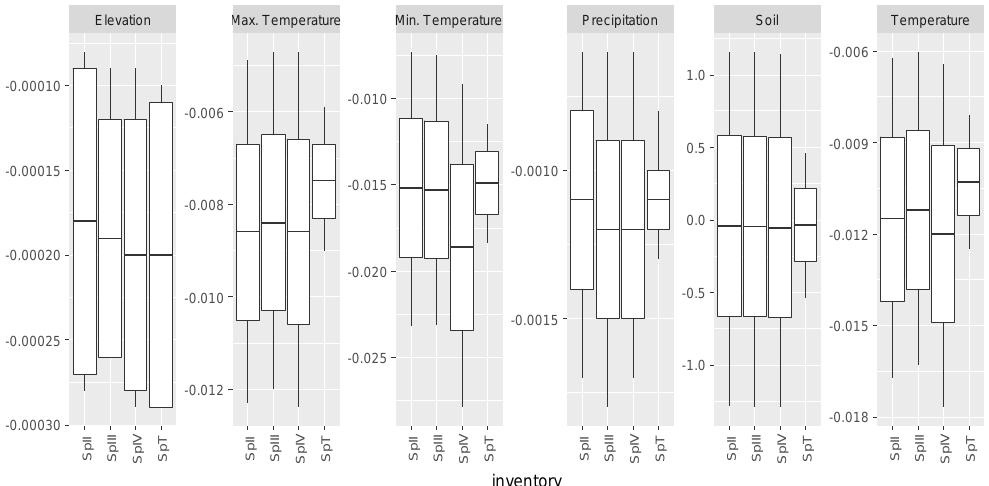
Figure 4. Boxplot diagram for the posterior estimates of the covariates for A. alba models: Spatial model II inventory (SpII); Spatial model III inventory (SpIII); Spatial model IV inventory (SpIV); Spatio-temporal model